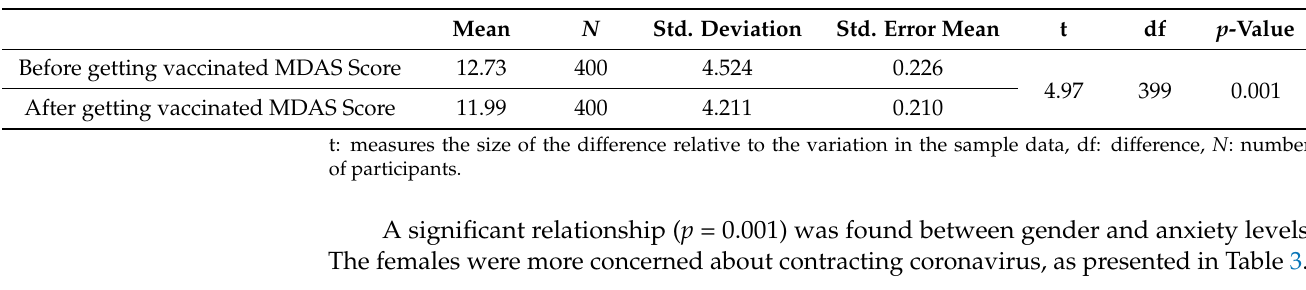
Table 3. Relationship of anxiety scores in both sexes (n = 400).